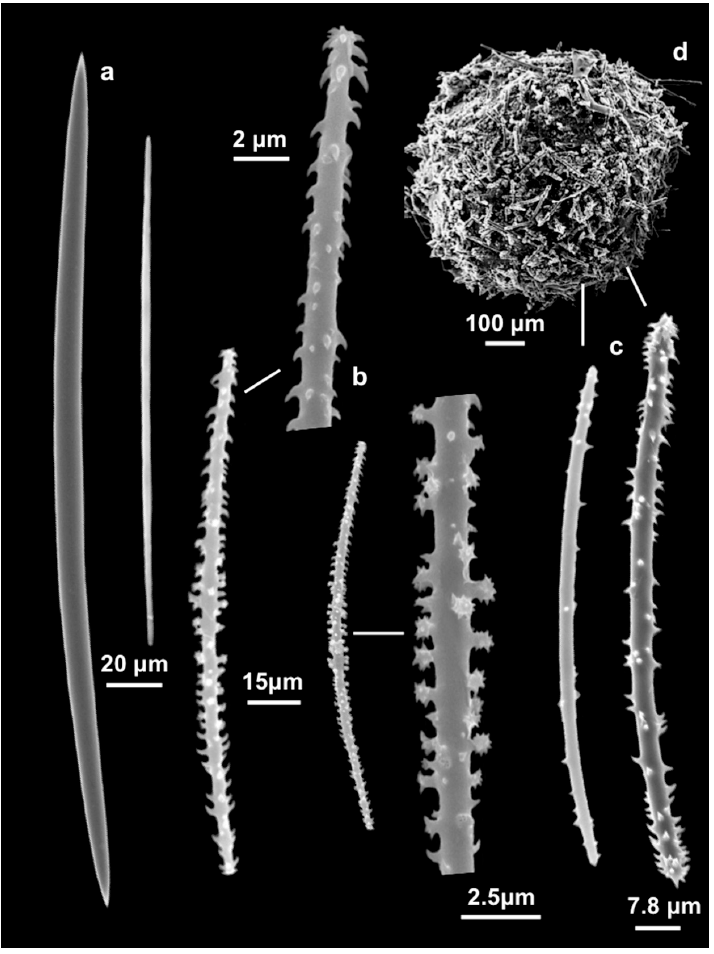
Figure 4. Spongilla manconiae sp. nov. SEM images of spicules. ( a ) Oxeas; ( b ) Microxeas, with magnification of the spines; ( c ) Gemmuloscleres; ( d ) Gemmule.